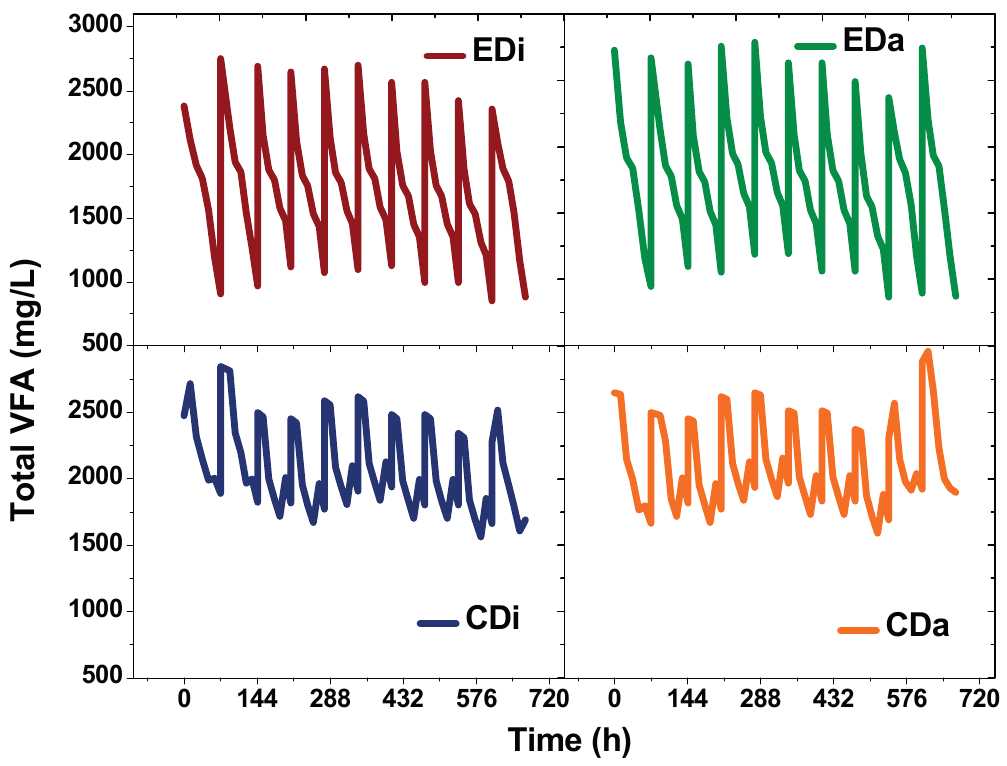
Figure 5. Total volatile fatty acids (VFA) profile in dark-fermentative system (DFS-CDi, CDa) and augmented dark-photo fermentative system (ADPFS-EDi, EDa) as a function of time with dairy and distillery